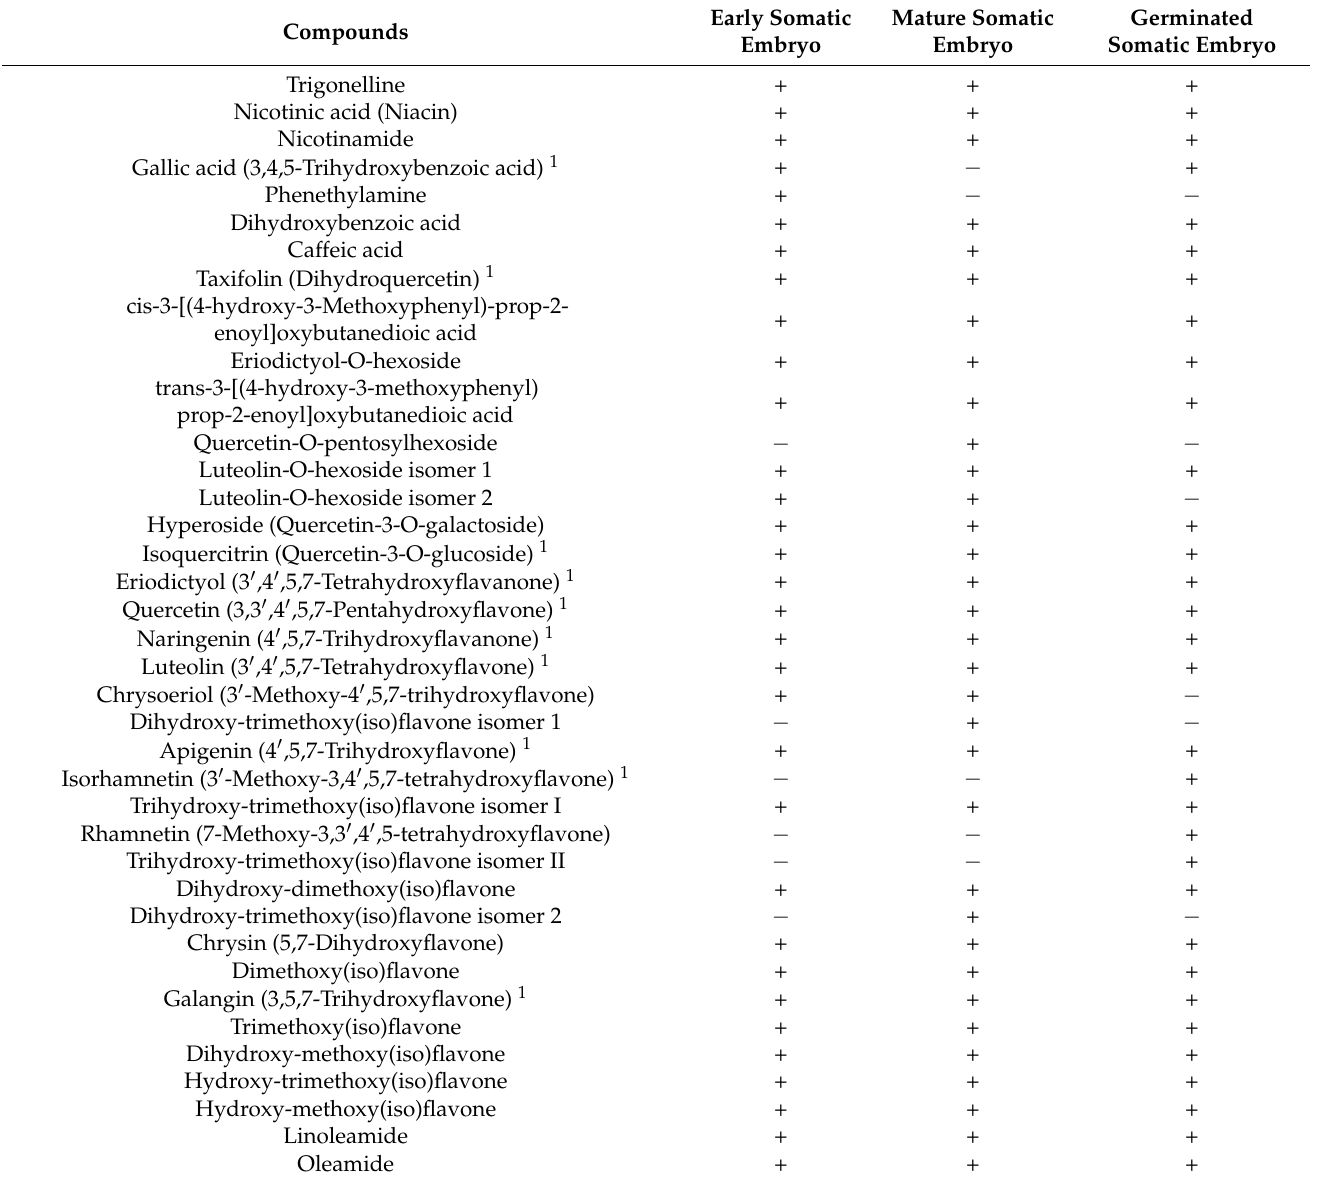
Table 4. Chemical composition of Cotyledon orbiculata extracts. Compounds